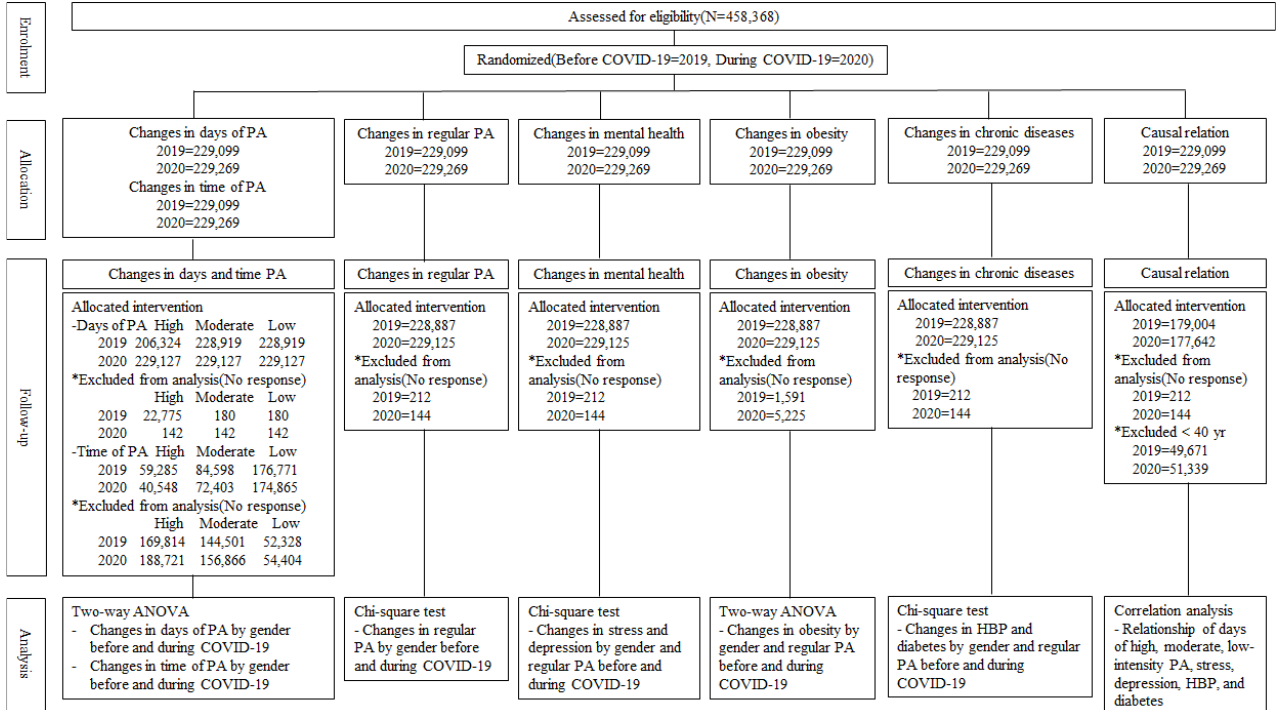
Table 1. Characteristics of